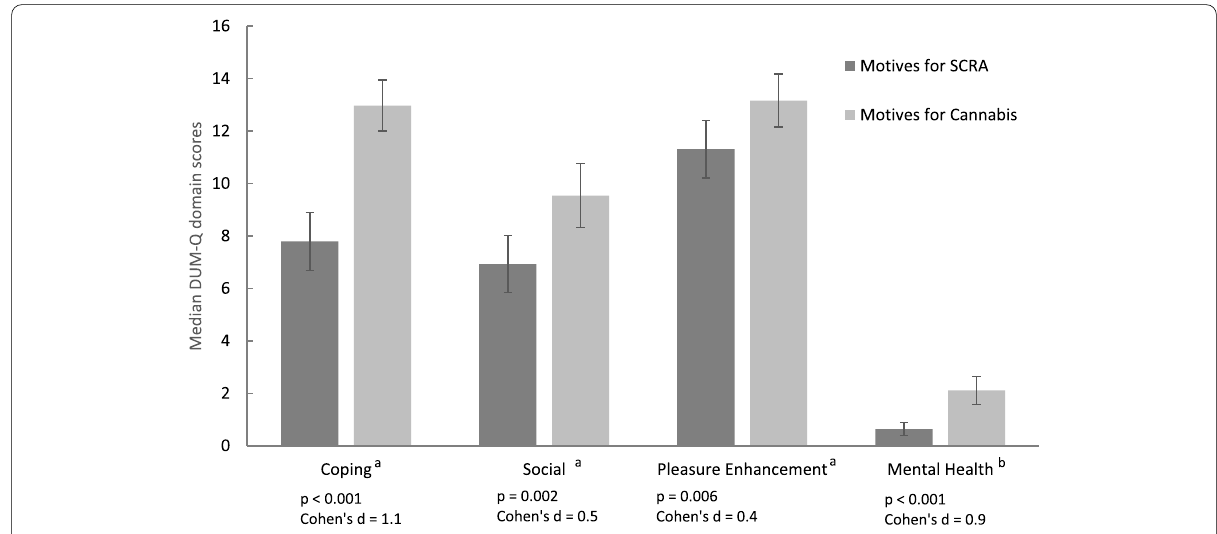
Fig. 1 Difference in median Drug Use Motives Questionnaire (DUM-Q) domain scores for SCRAs and cannabis. a The Coping, Social and Pleasure Enhancement domains consist of 4 items, each with a 5-point response option scored 0 to 4 respectively (never often 3, almost always 4). b The Mental Health domain consists of only 2 items, each with the same response and scoring as = =